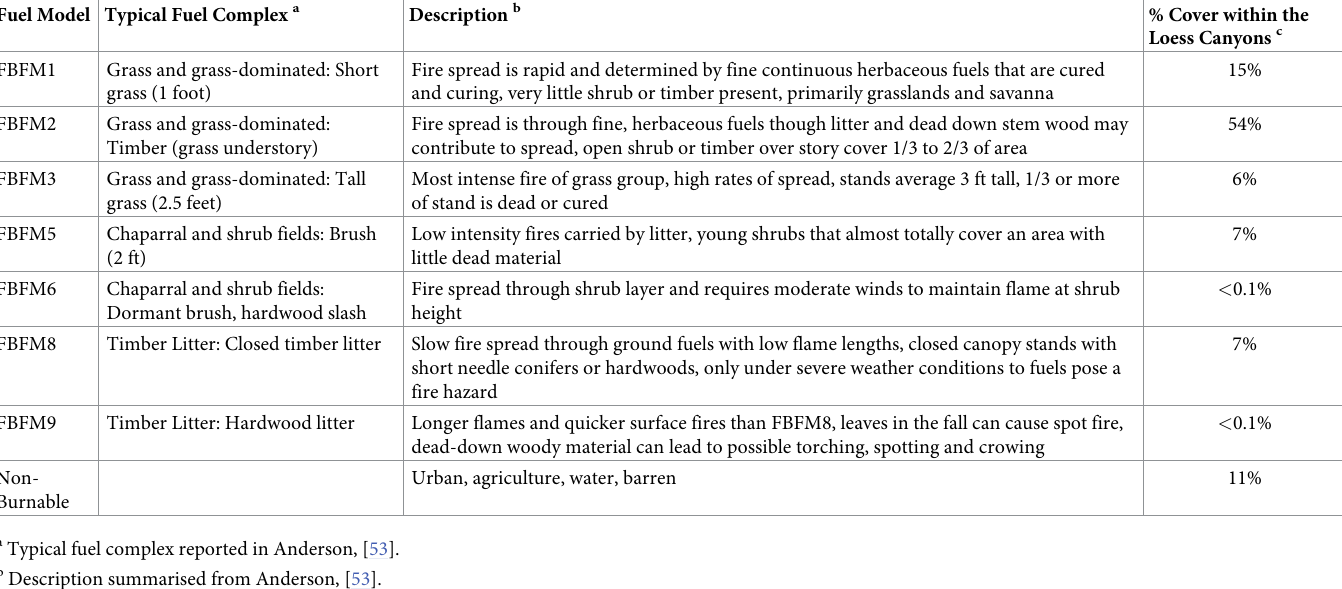
Table 1. Summary of fuel models and their percent cover within the Loess Canyons. Fuel models and descriptions are from Anderson, [53]. The percent cover of each fuel model type within the Loess Canyons and a surrounding 5 mile buffer were calculated using data from LANDFIRE